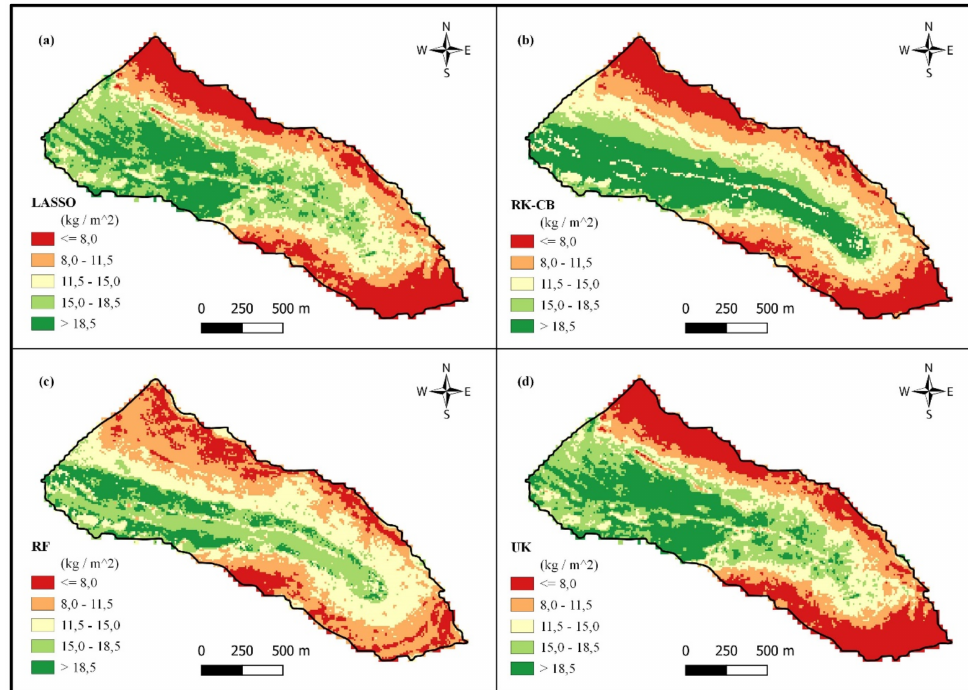
Figure 5. A comparison between the M1 catchment’s ( a ) LASSO, ( b ) RK-CB, ( c ) RF, and ( d ) UK, in order of their performance in regard to error (NRMSE).